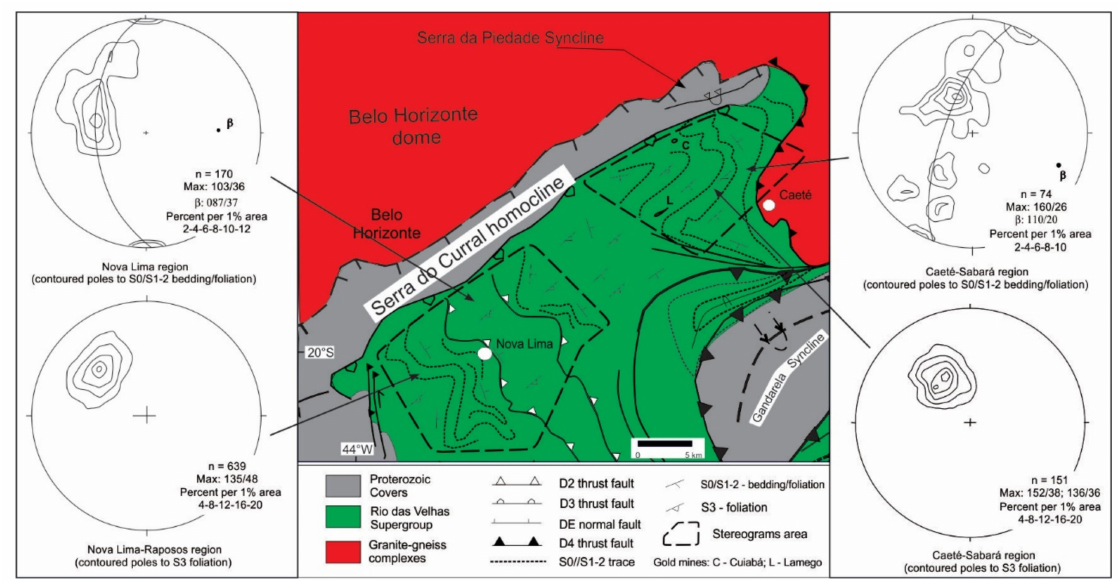
Figure 15. Equal-area, lower hemisphere stereo plots of S0 / S1–2 bedding / foliation (D1–D2 phases) and S3 foliation planes (D3 phase) for the Nova Lima Group in the Nova Lima and Caet é